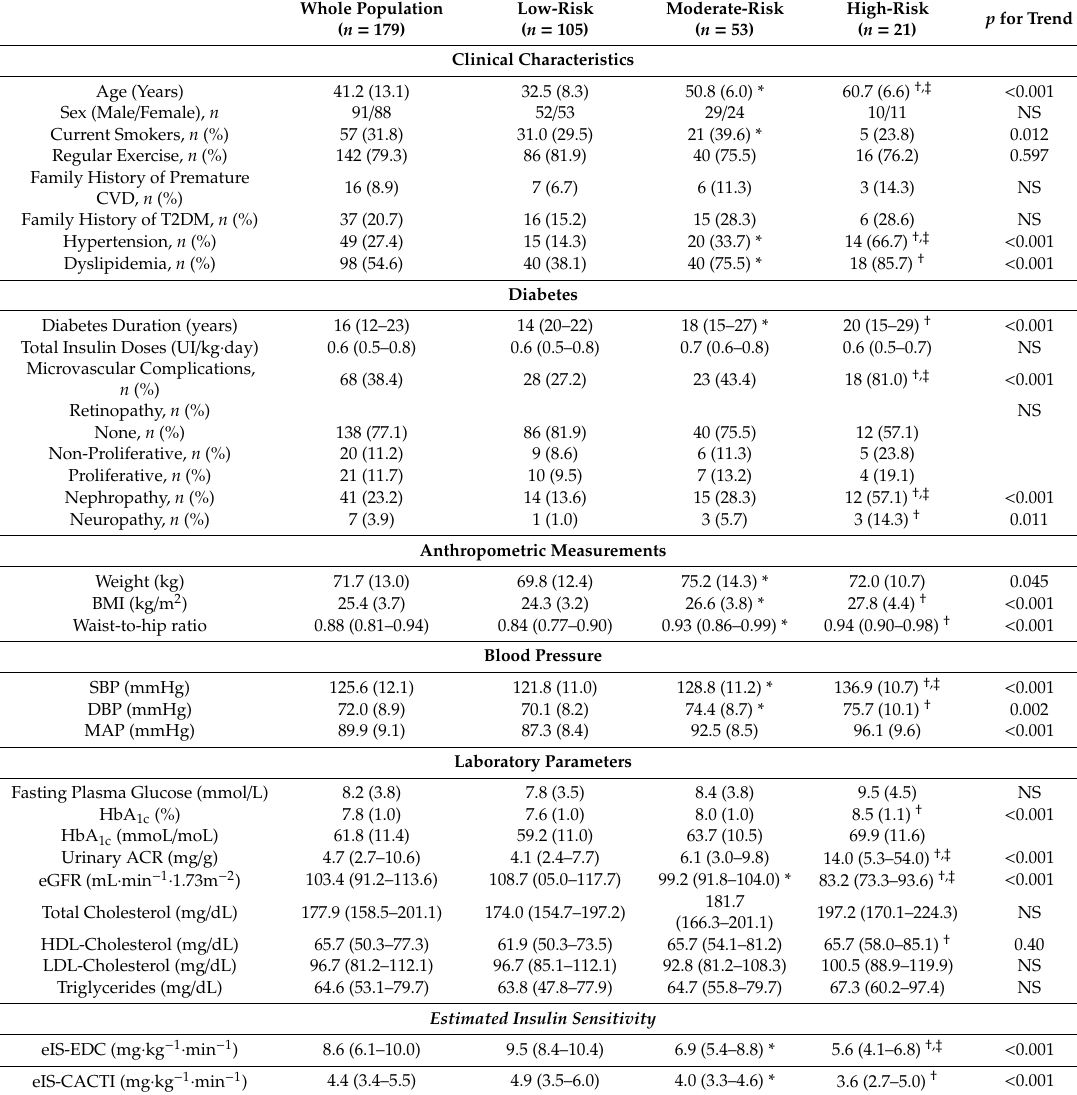
Table 1. Clinical and metabolic characteristics of patients with type 1 diabetes stratified by 10-year cardiovascular disease (CVD) risk according to the Steno Type 1 Risk